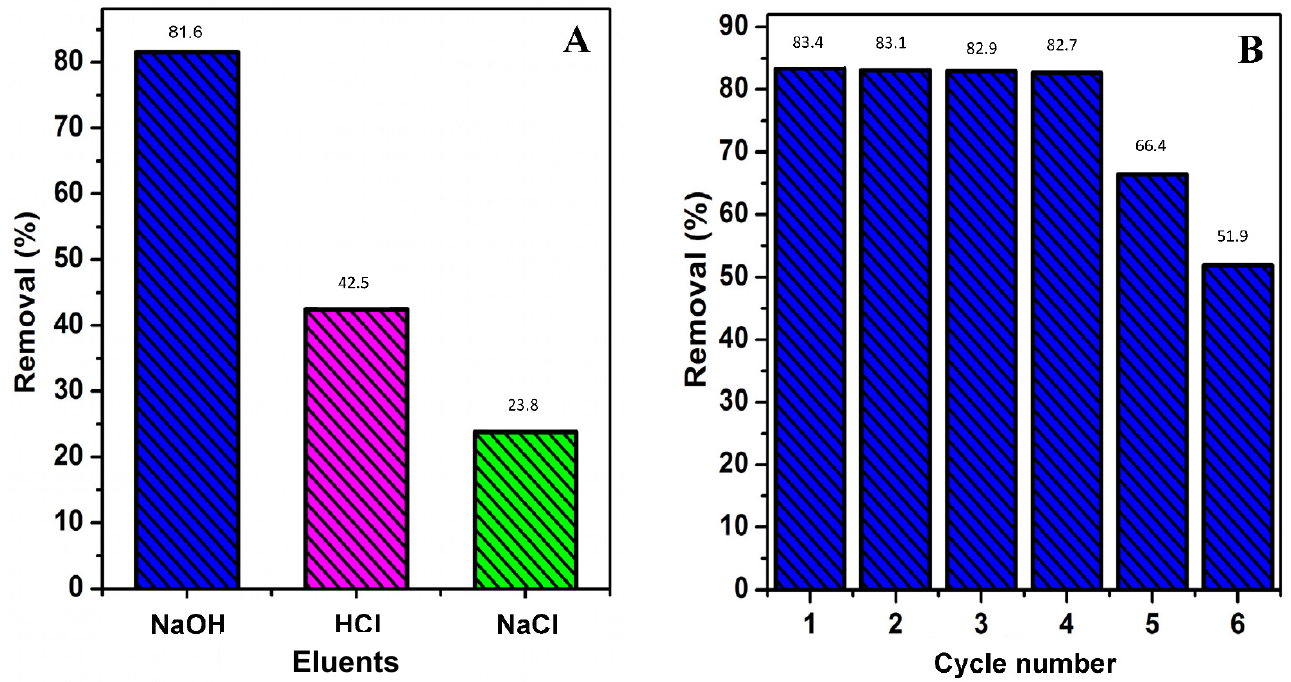
Figure 5. Desorption ( A ) and regeneration ( B ) studies plots.